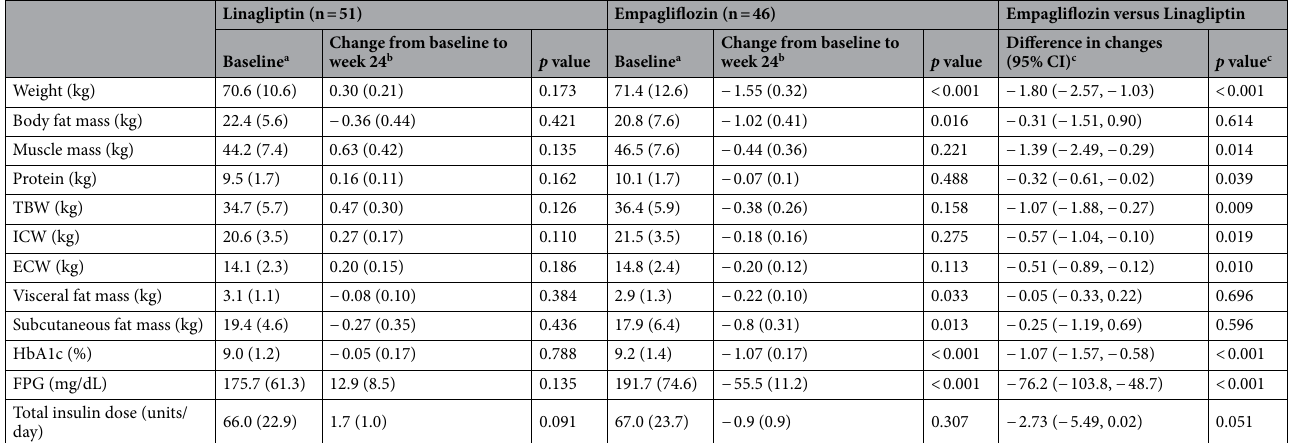
Table 2. Comparisons of body weight and body composition changes between the empagliflozin and linagliptin groups. a Data are mean (SD), b Data are mean (se), c Comparisons of changes from baseline to week 24 levels between the empagliflozin and linagliptin groups using multiple linear regression adjusting for gender. TBW total body water, ICW intracellular water, ECW extracellular water, HbA1c glycated hemoglobin, FPG fasting plasma